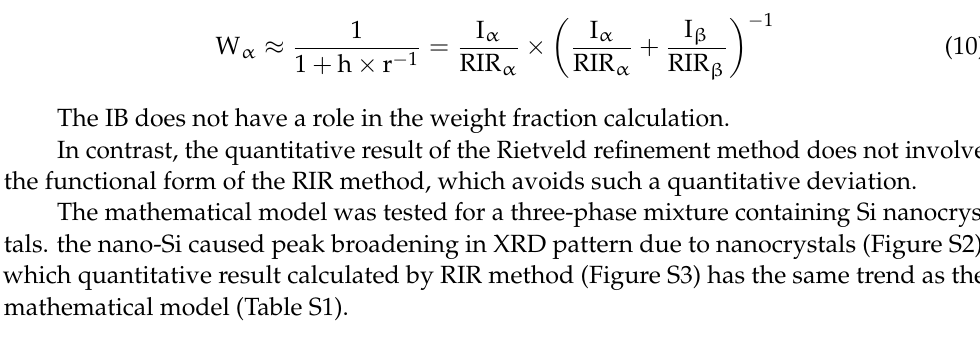
from left to right are the strongest peaks of nano-Si, CaCO 3 , ZnO; Table S1: Integral area of each phase and quantitative result of RIR